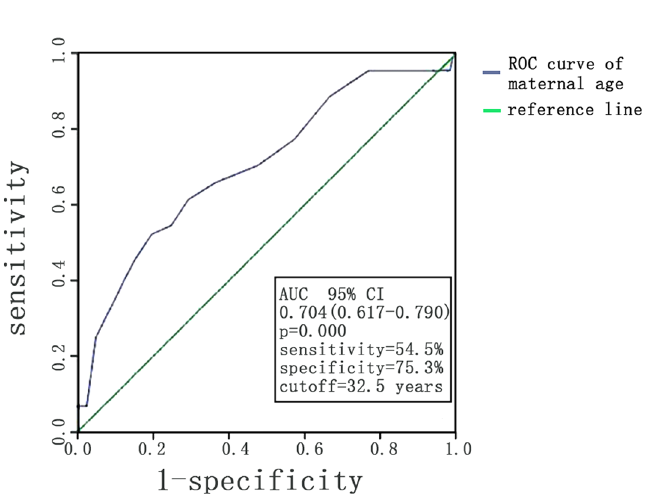
Figure 1. ROC curve analysis of maternal age to differentiate maternal women with cardiac diastolic function decline from those without cardiac diastolic function